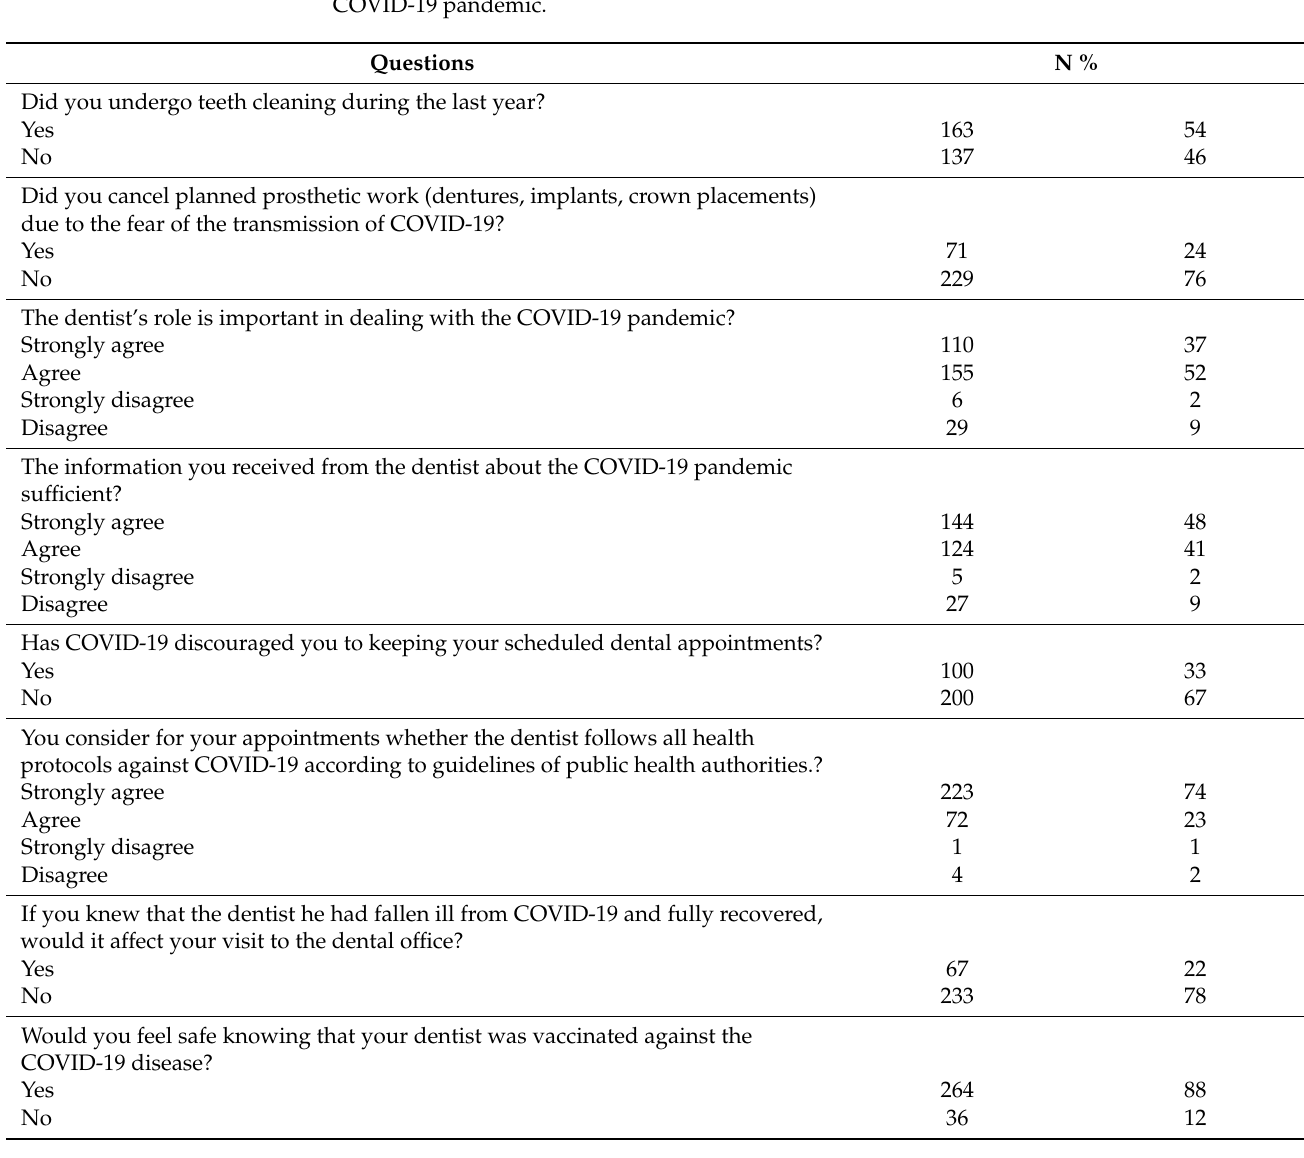
Table 2. Dental patients and their compliance with primary health care services during the period of COVID-19